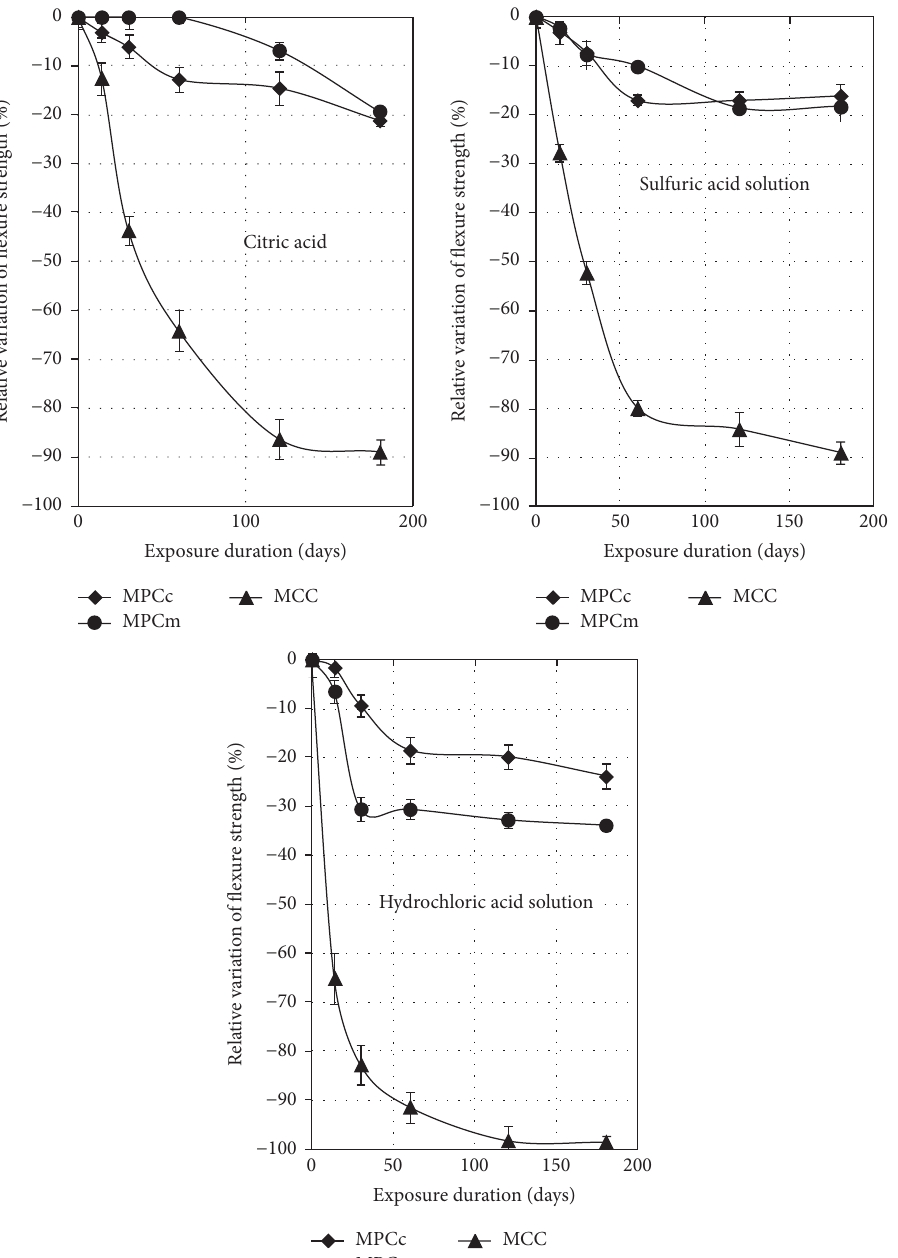
Figure 8: Relative variation of flexural strength as a function of immersion